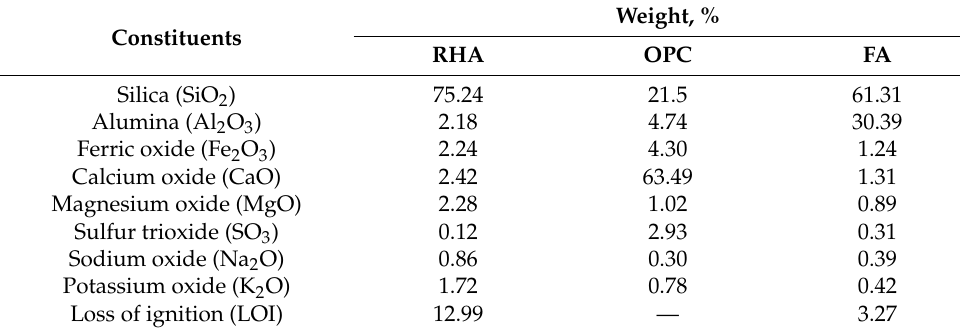
Table 1. Chemical Composition of RHA, OPC, and Fly Ash (FA).